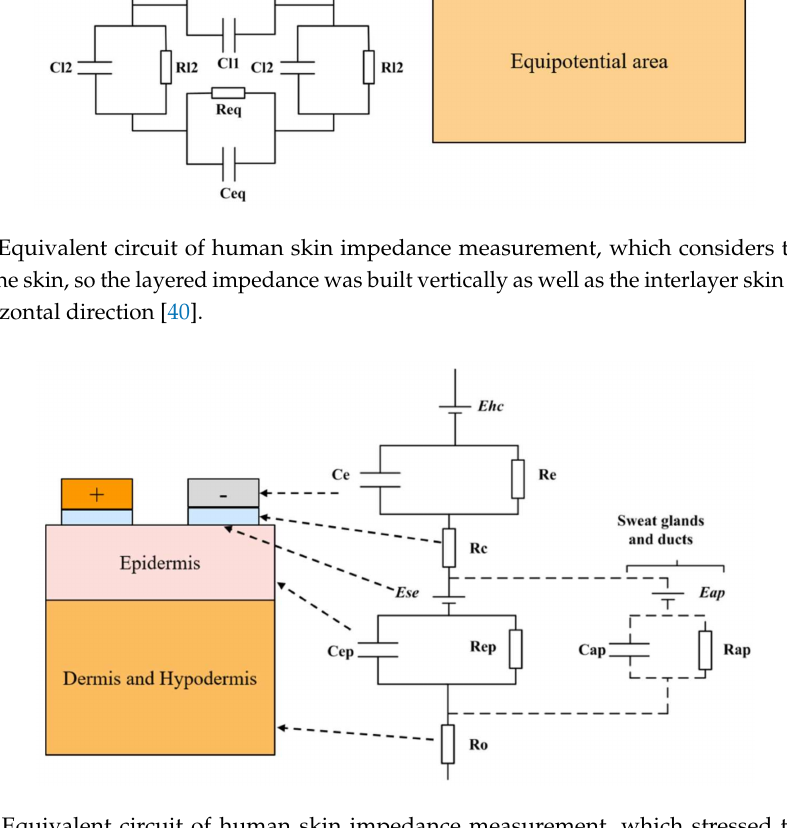
Figure 5. Equivalent circuit of human skin impedance measurement, which stressed the layered structure and the skin appendages [12]. Table 2. The characteristics of two impedance